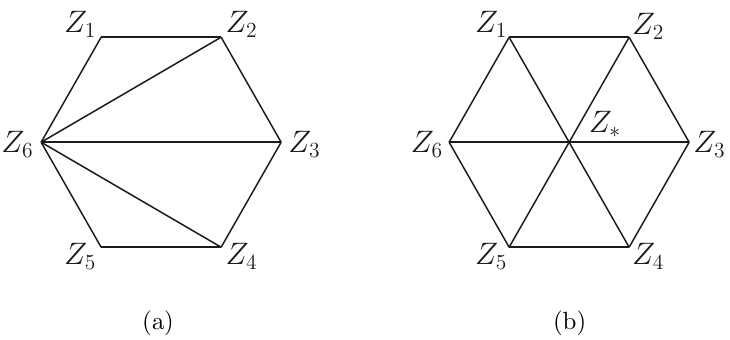
Figure 2 . Two possibilities for triangulating a polygon. BCFW give a generalisation of the (cid:12)rst whereas WLDs give a generalisation of the second (for